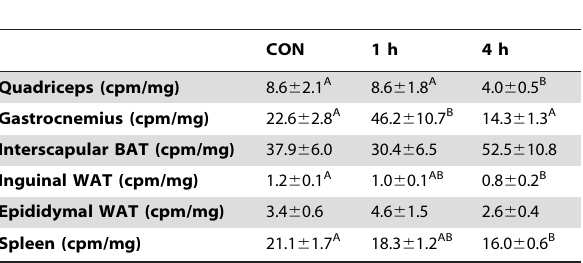
Table 3. Tissue 2-deoxyglucose uptake.